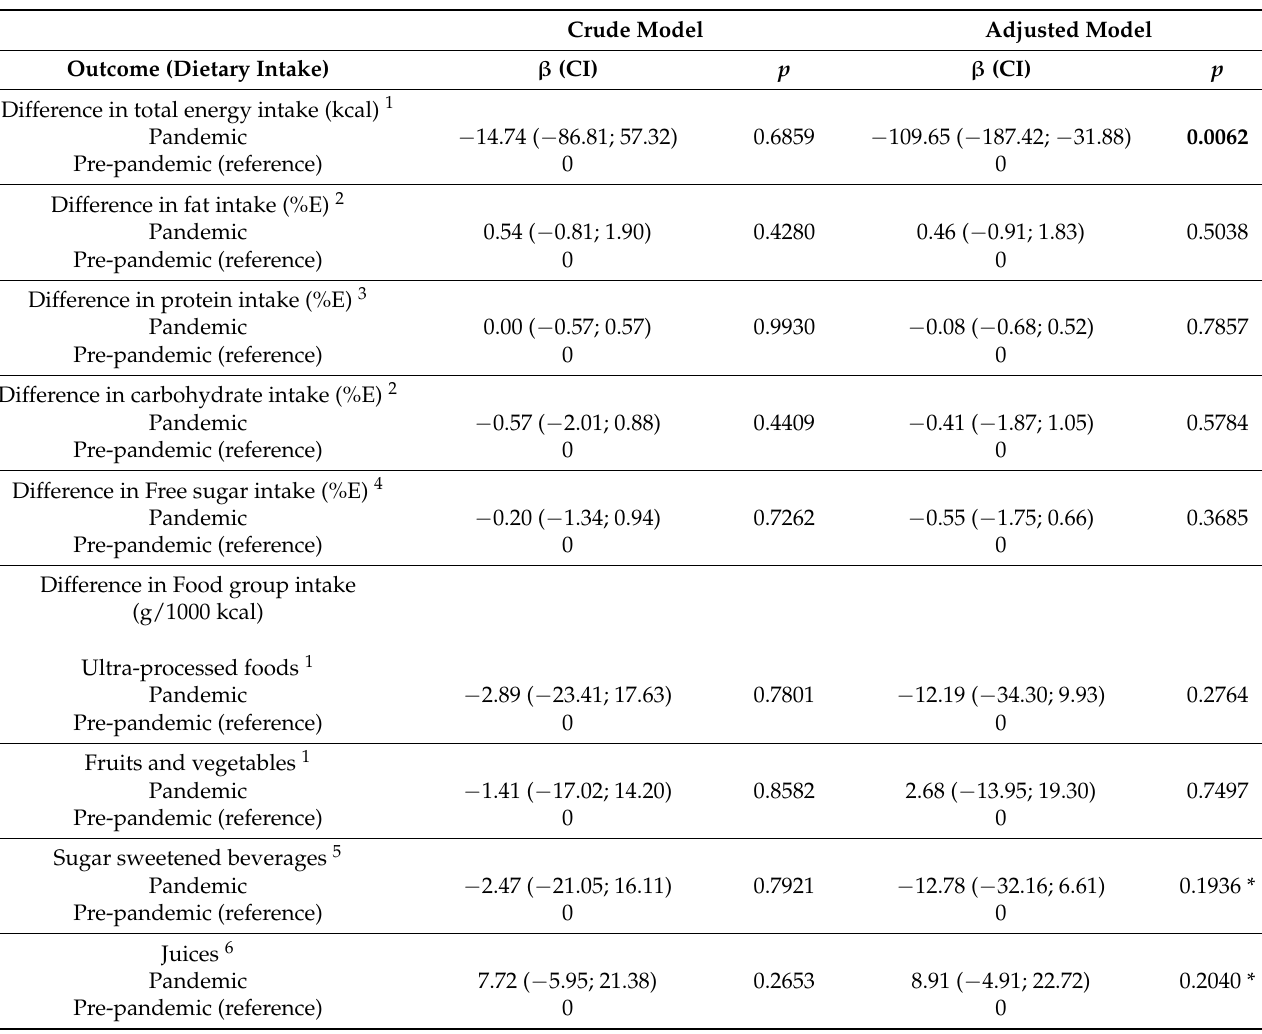
Table 4. Dietary intake during the COVID-19 pandemic in 2020 compared to pre-pandemic intake. Crude Model Adjusted